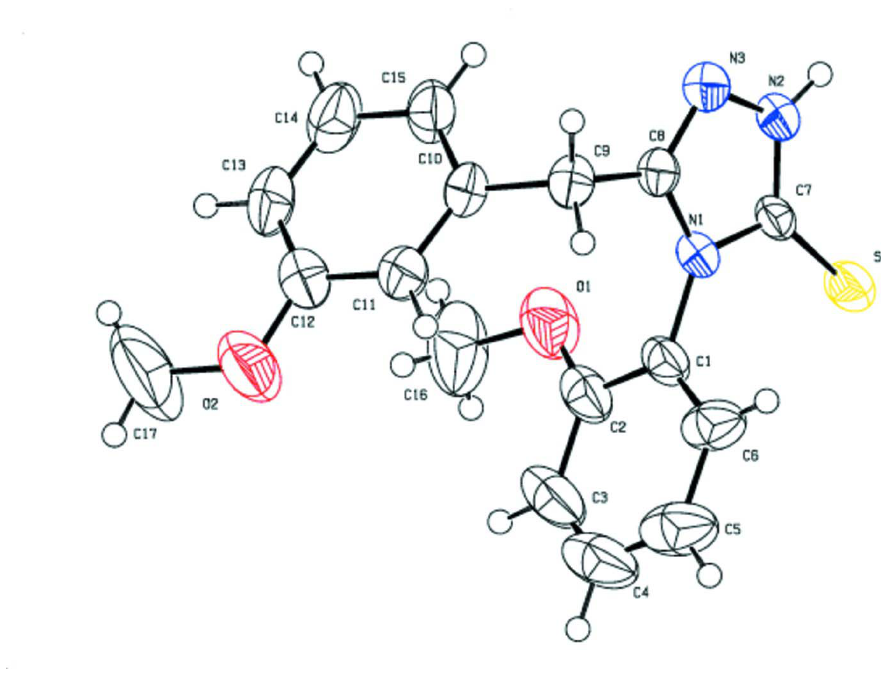
Figure 1 The molecular structure of (I) with 50% probability displacement ellipsoids (arbitrary spheres for H atoms).